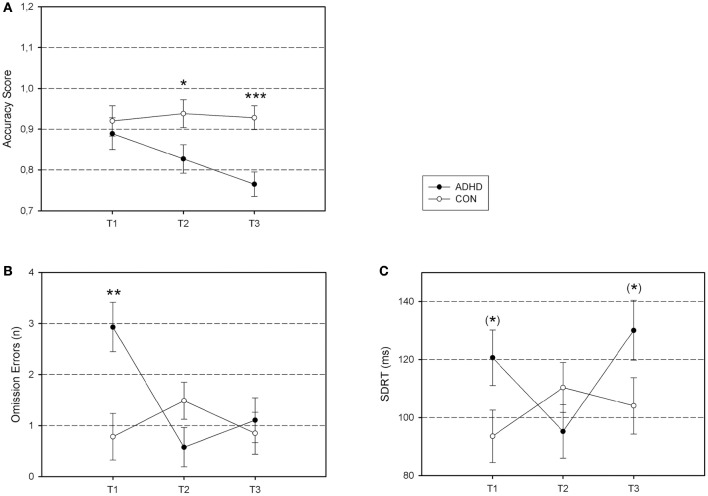
Differential group effects of repeated task exposure. (A) Time Reproduction Accuracy; (B) CPT Omission Errors; (C) CPT Response Time Variability. Accuracy Score, the estimated time interval divided by the time interval to be produced in order to evaluate under- or overestimation in milliseconds (Time Reproduction); Omission Errors, number of targets that were not identified (CPT); SDRT, standard deviation of reaction time for correctly identified targets in milliseconds (CPT). ADHD, ADHD group; CON, control group. ***p < 0.001; **p < 0.01; *p < 0.05; (*)p < 0.10.